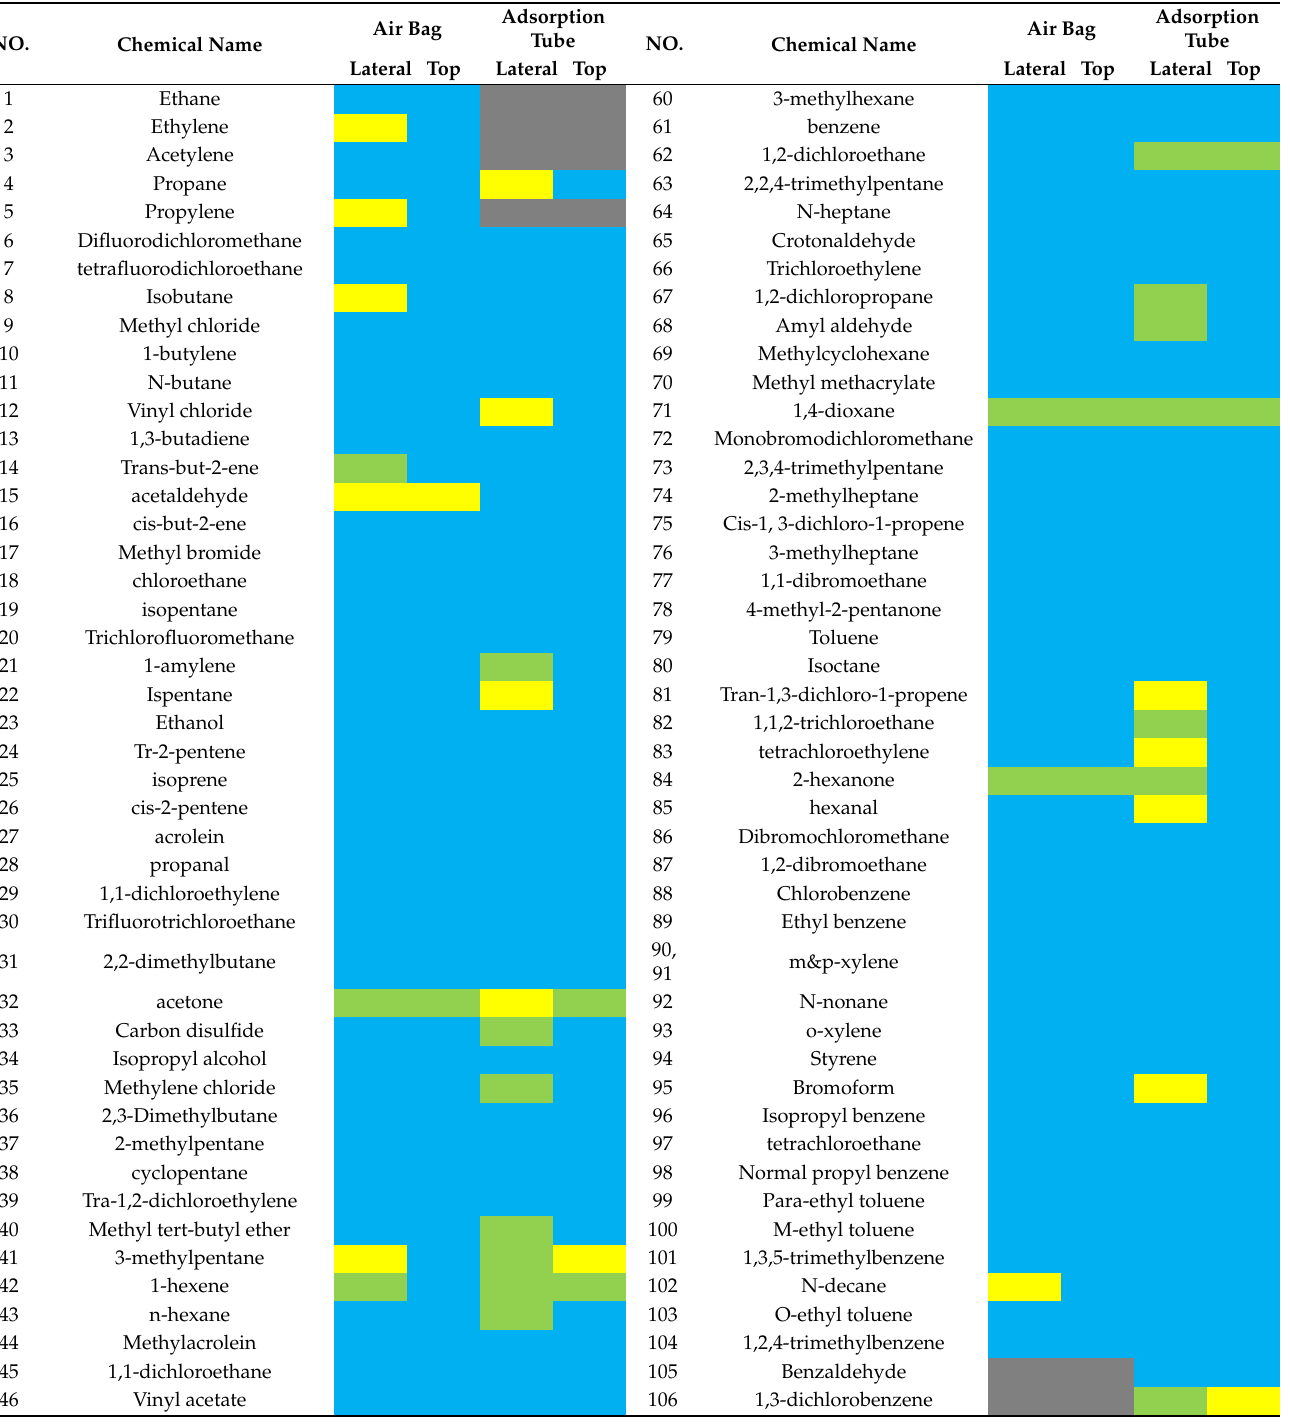
Table 3. The results of the comparison experiment (n =